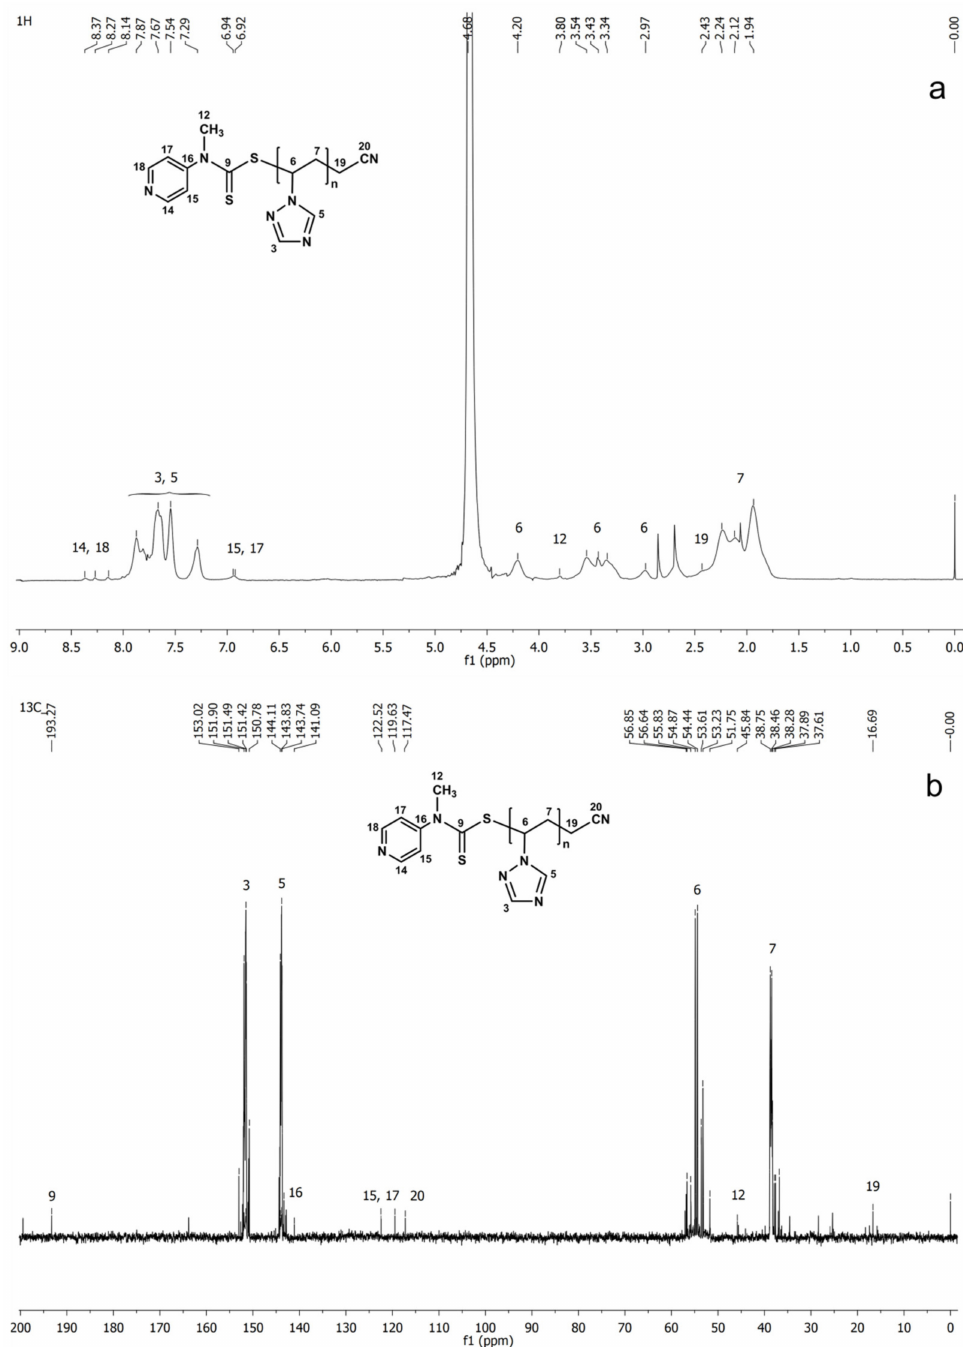
Figure 3. The 1 H ( a ) and 13 C ( b ) NMR spectra of PVT (Table 2, 12) in D 2 O. Kinetic studies of VT radical polymerization in the presence of [AIBN]:[CTA2] = 1:2 in DMF at 60 ◦ C were carried out in order to confirm the controlled nature of the poly- merization. The conversion and molecular weight characteristics of PVT from the time of polymerization were controlled. The conversion, average molecular weight, and polydis- persity of the homopolymer in the reaction mixture were determined by